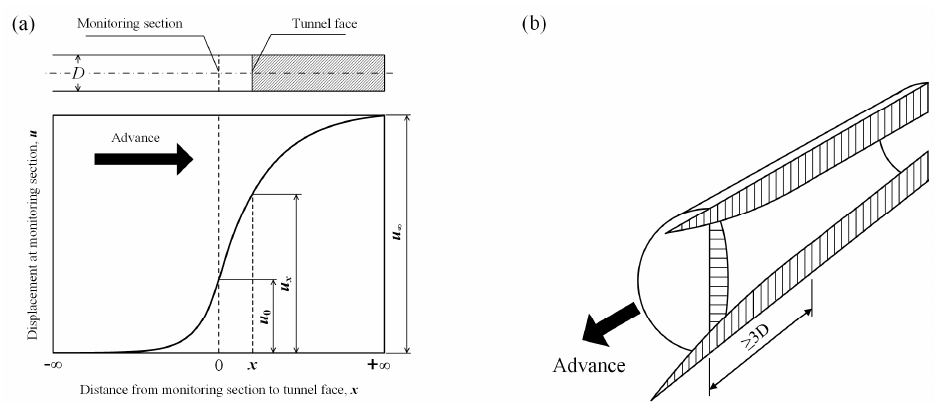
Figure 3. Longitudinal displacement profile [30]: ( a ) the meaning of Longitudinal Displacement Profile (LDP), ( b ) the face effect. Adapt from “Improved Longitudinal Displacement Profiles for Convergence Confinement Analysis of Deep Tunnels” by Vlachopoulos, N. and Diederichs, M.S., 2009, 42, pp. 975–979. Copyright 2020 by Springer Nature. Adapt with permission.